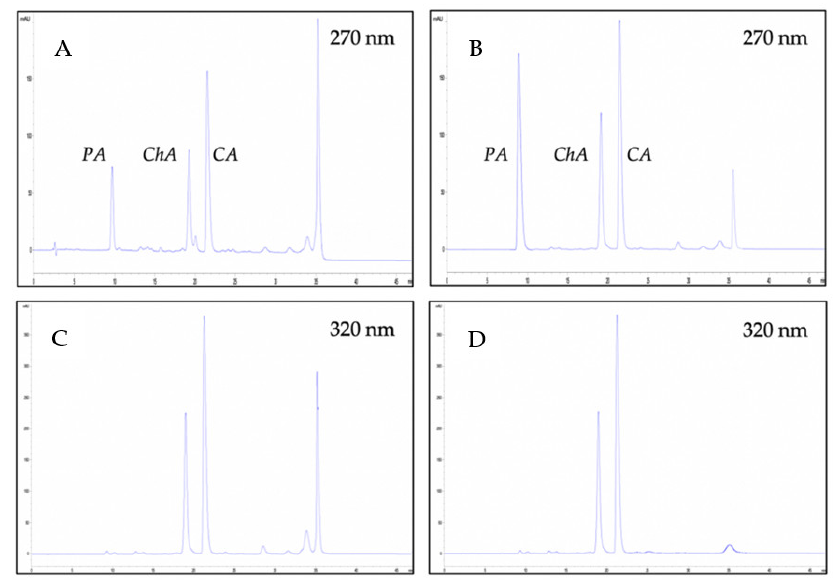
Figure 1. HPLC profiles of FEPC at 270 nm ( A ) and 320 nm ( C ); and HPLC profile of protocatechuic acid (PA), chlorogenic acid (ChA) and caffeic acid (CA) standards mix at 270 nm ( B ) and 320 nm ( D